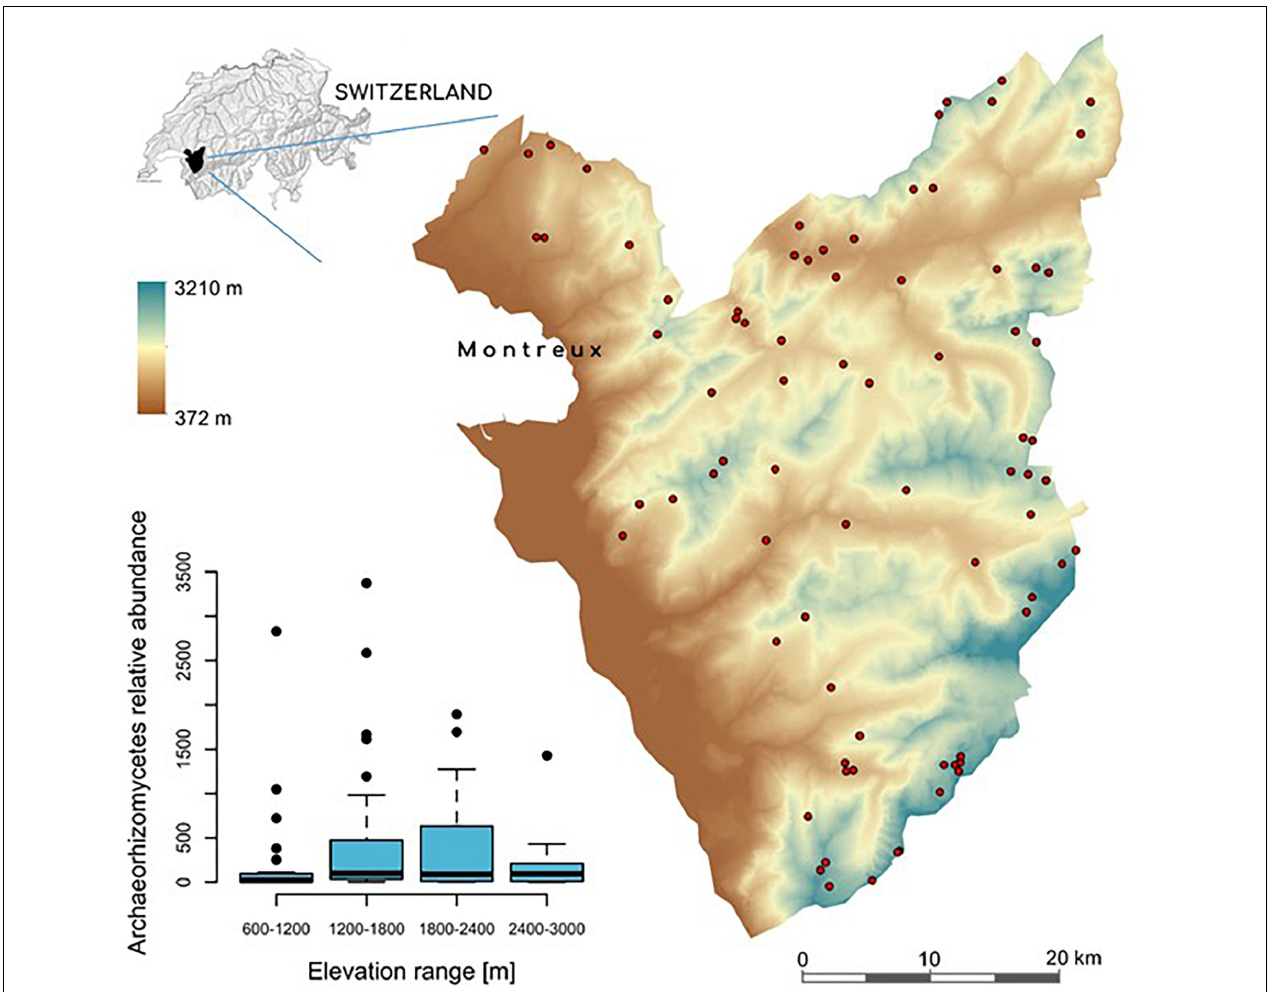
FIGURE 1 | Digital elevation model (DEM) of the study area in the Western Swiss Alps (700 km 2 ). The small map on the top left shows the location of the study area, colored in black, within Switzerland. Red dots correspond to the 103 sampling sites across the > 2,500 m-wide elevation gradient. The boxplot on the bottom left, represents the relative abundance of Archaeorhizomycetes OTUs across all samples, categorized in elevational bins.